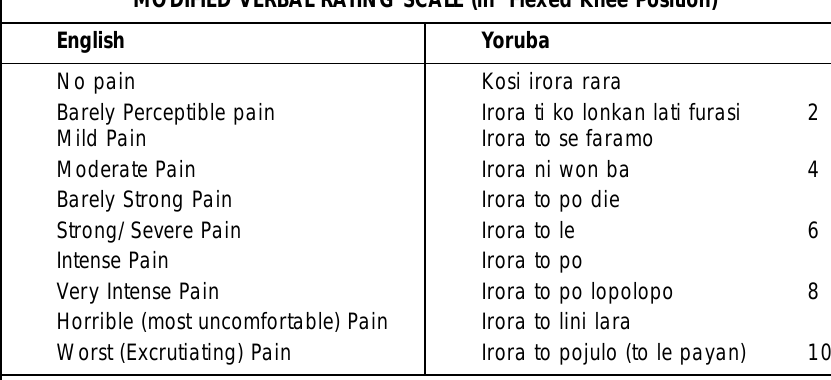
MODIFIED VERBAL RATING SCALE (in Flexed Knee